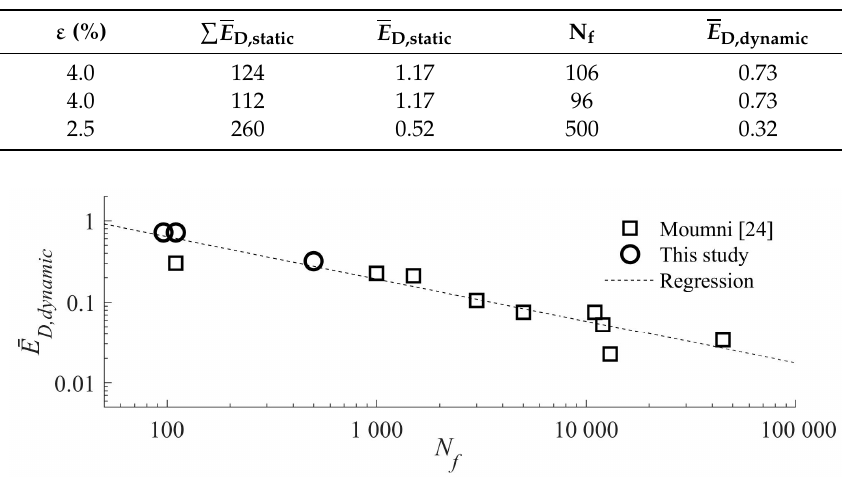
Figure 13. Normalized energy dissipation versus the number of cycles to failure.